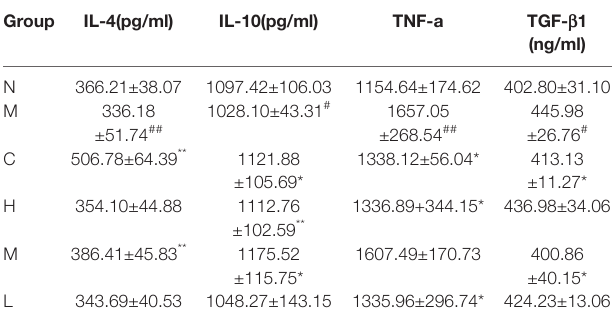
Data are presented as mean ± SD. n = 8 per group. **P < 0.01 vs. control group, ## P < 0.01 vs. model. H, high-dose; M, middle-dose; L, low-dose; N, normal; M, model.